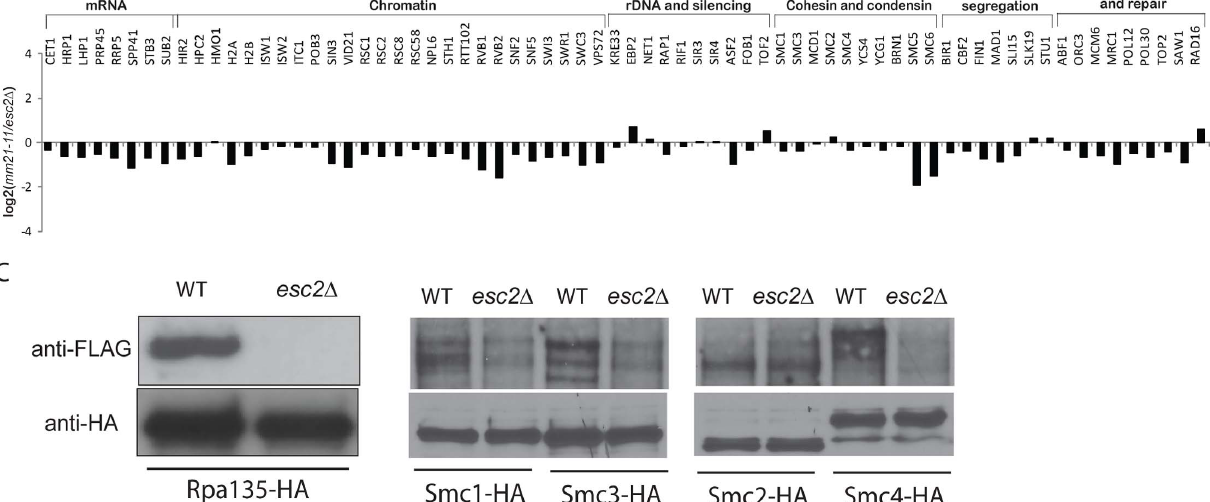
in sumoylated proteins (Figure 2), caused a further increase in sumoylation of cohesion and condensin subunits when com- bined with deletion of SLX5 (Figure 5B, Table S12). As expected, Siz1-specific targets such as septins and Pol30 were not appreciably affected in the siz2 D slx5 D mutant. Thus, the deletion of SLX5 increases sumoylation of Mms21-specific